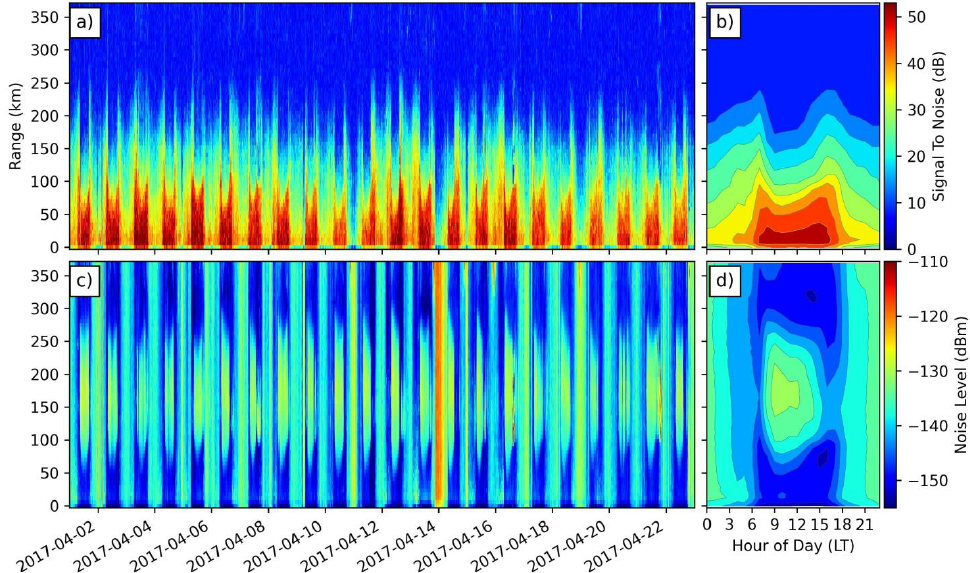
Figure 4. HFR backscatter spectra timeseries from KAYA between 1 April 2017 and 22 April 2017 for ( a ) SCNR and ( c ) C+NF, and the hour-of-the-day mean for ( b ) SCNR and ( d ) C+NF. The description of the timeseries at KAYA resembles ANGU as in Figure 3.